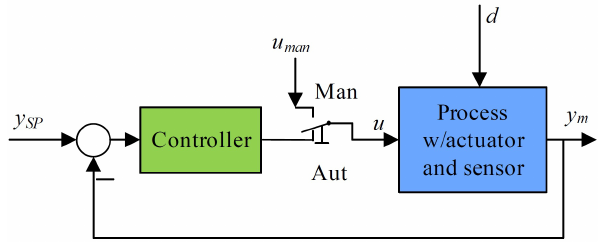
Figure 1: The Good Gain method for PID tuning is ap- plied to the established control